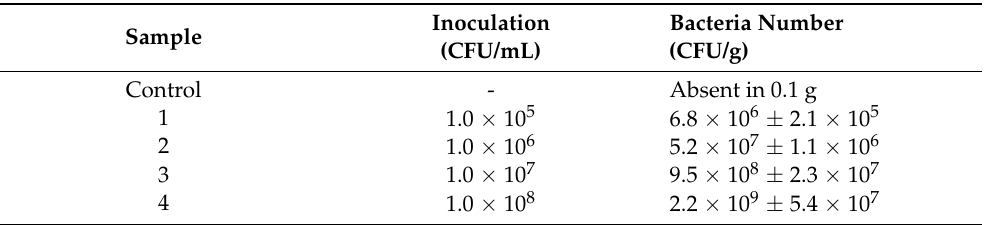
Table 1. Determined number of bacteria in the tested mortadella samples (mean values ± standard